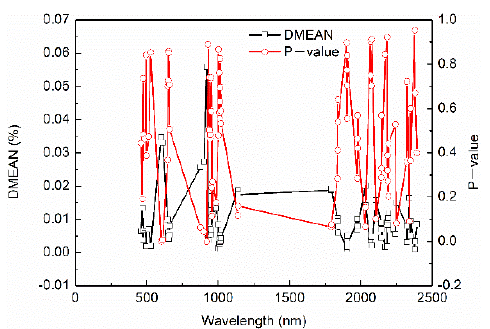
Figure 3. DMEAN and P–values of the nonparametric Mann–Whitney U test on variable.